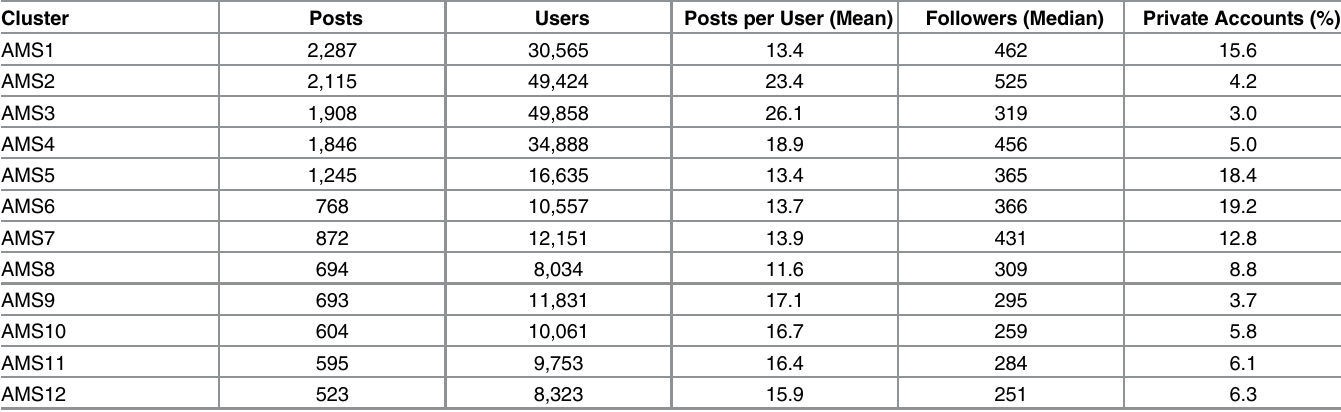
Table 2. Clusters detected in Amsterdam.